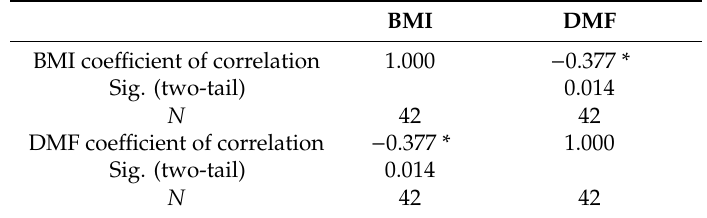
Table 14. Data related to the correlation between BMI and DMF in patients with a Class II molar relationship. BMI DMF BMI coe ffi cient of correlation Sig. (two-tail) N